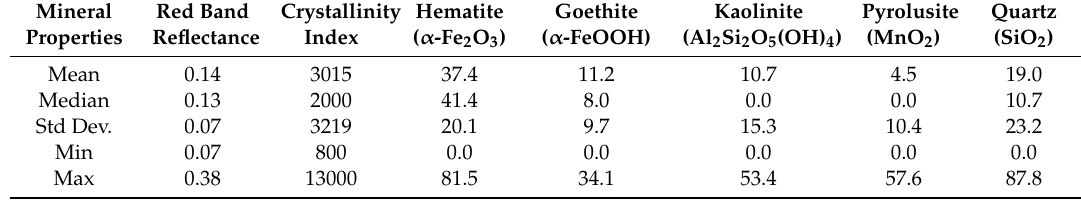
Table 1. Major properties of sampled rock wastes. Mineralogical properties ( a ), including major mineral phases (%) occurring in > 30% of total samples are shown along with the content of major ( b ) and trace ( c )